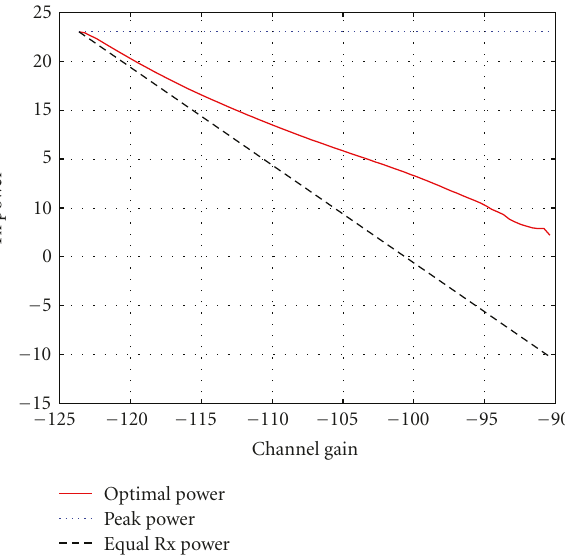
Figure 4: Optimal power allocation when w = 20kHz.